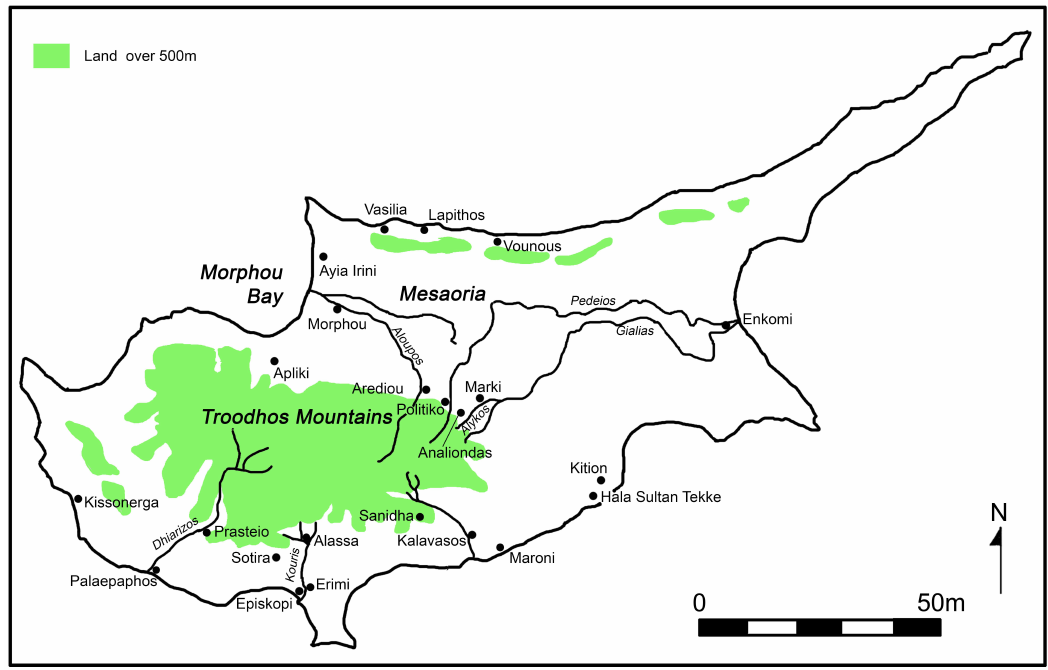
Figure 1. Map of Bronze Age Cyprus, indicating sites and rivers mentioned in